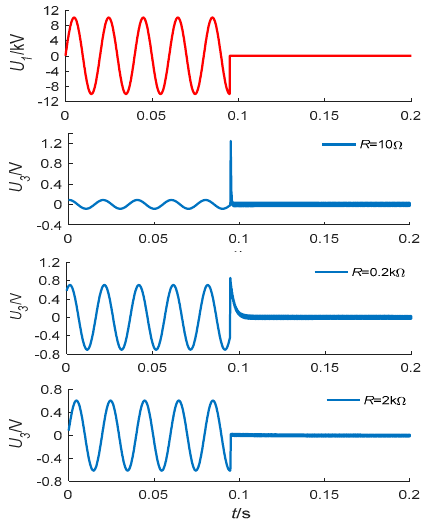
Figure 8. Input and output waveforms for different resistances.